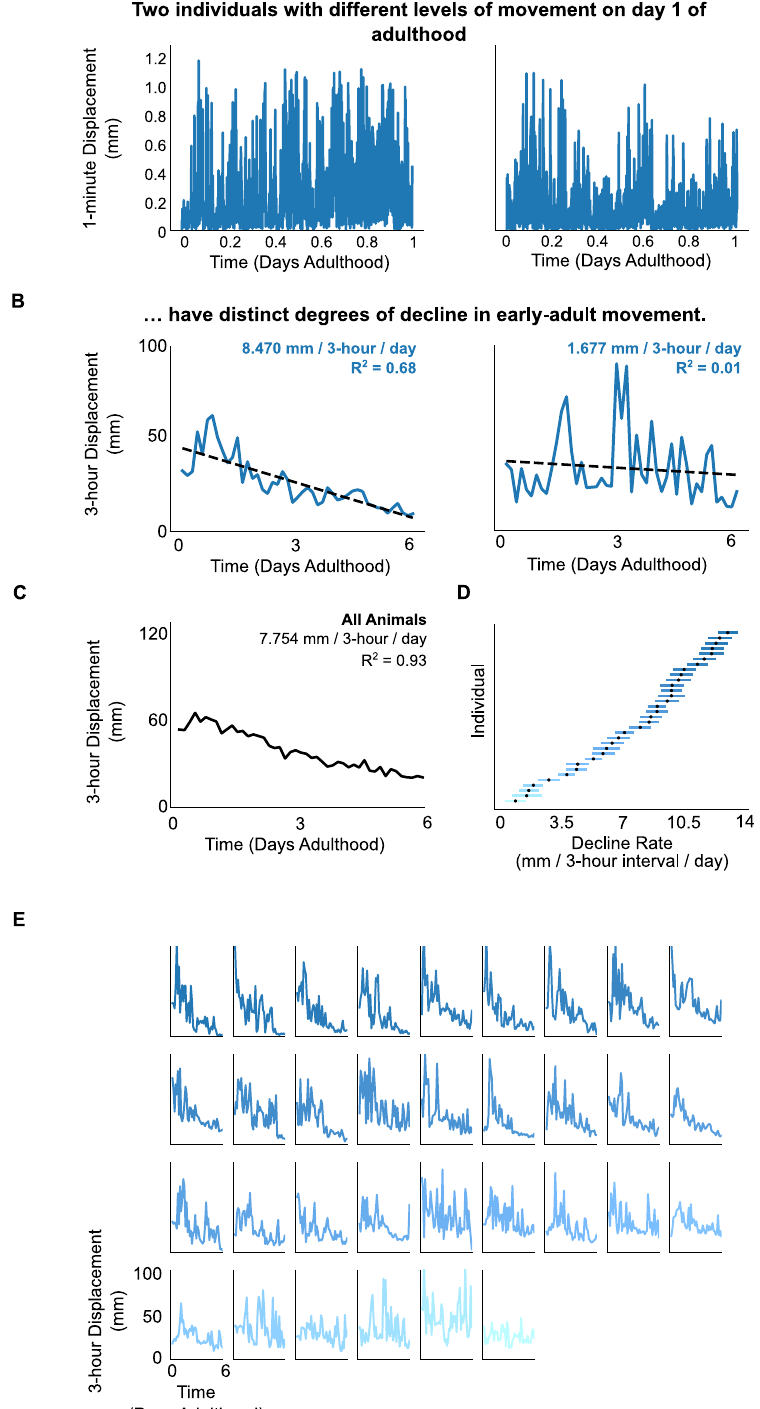
Fig 3. Animal movement shows substantial decline during early-adult life. (A) Examples of movement taken at 1 fpm during the first day of life. Shown are data from two individuals with relatively high ( left panel ) and low ( right panel ) movement. (B) Corresponding movement declines across the observation period for the respective individuals in (A), integrated over 3-hour intervals to yield 8 timepoints a day. Rates of decline and coefficients of determination are estimated by linear regression. (C) Change in movement behavior averaged across all individuals during the